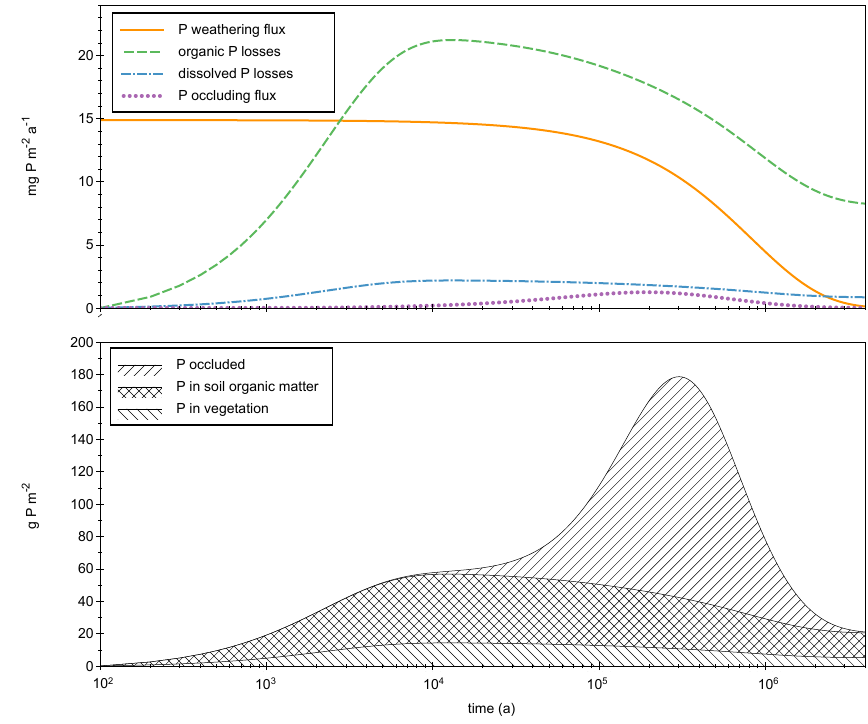
Fig. 6. P temporal dynamics for an ecosystem with a large initial amount of primary minerals. Simulated phosphorus transformation in time are shown using the parameters for Hawaii given in Tables 2 and 3. The upper figure shows how the fluxes change during soil evolution. The lower figure represents the pools. For this transient solution we do not represent the P weatherable pool as it is not comparable with Crews et al. (1995) who only measured the first 50cm, while our simulation started with 5m of parent material. However, weathering is comparable to Chadwick et al. (1999) weathering rates for Hawaii, which starts at about 20mgPm 2 a − 1 at about 2000 a and goes to 0,1mgPm 2 a − 1 at about 4Ma. Note that the x-axis is plotted on a logarithmic